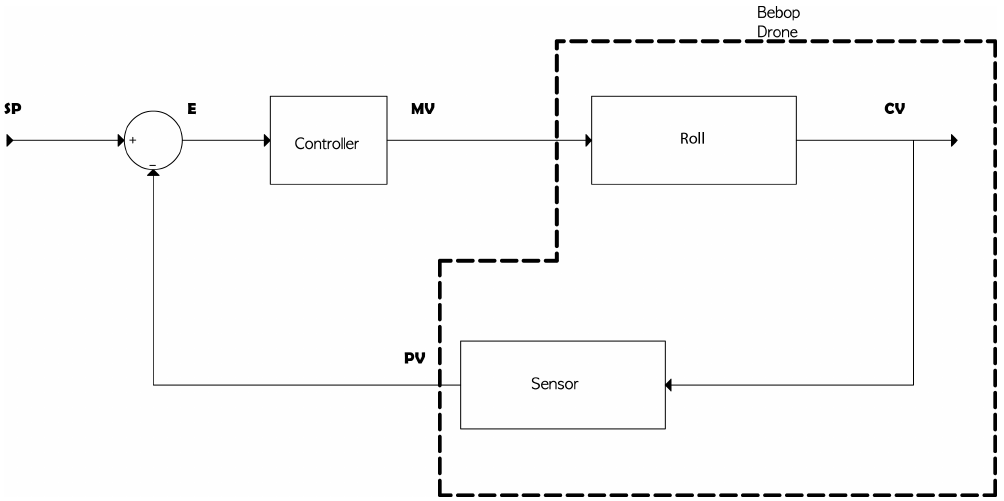
Figure 12. Control system in closed-loop. Set point (SP), Error (E), Manipulated variable (MV), Controlled variable (CV), Process variable